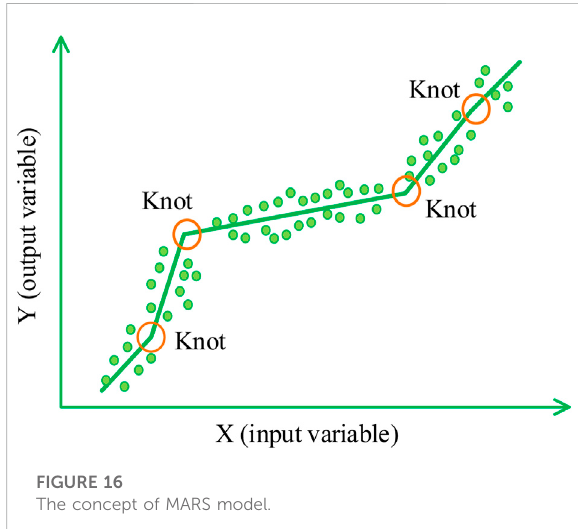
FIGURE 16 The concept of MARS